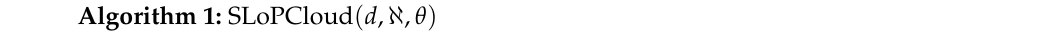
Algorithm 1: SLoPCloud ( d , ℵ , θ